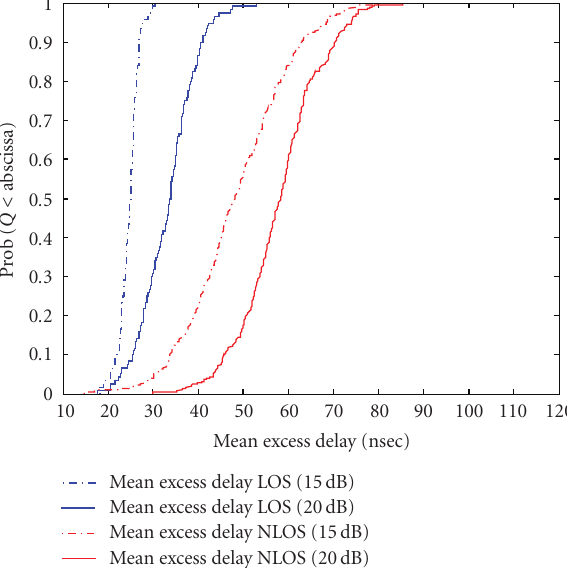
Figure 8: CDF of RMS delay spread values over LOS and NLOS cases. Figure 9: CDF of mean excess delay values over LOS and NLOS